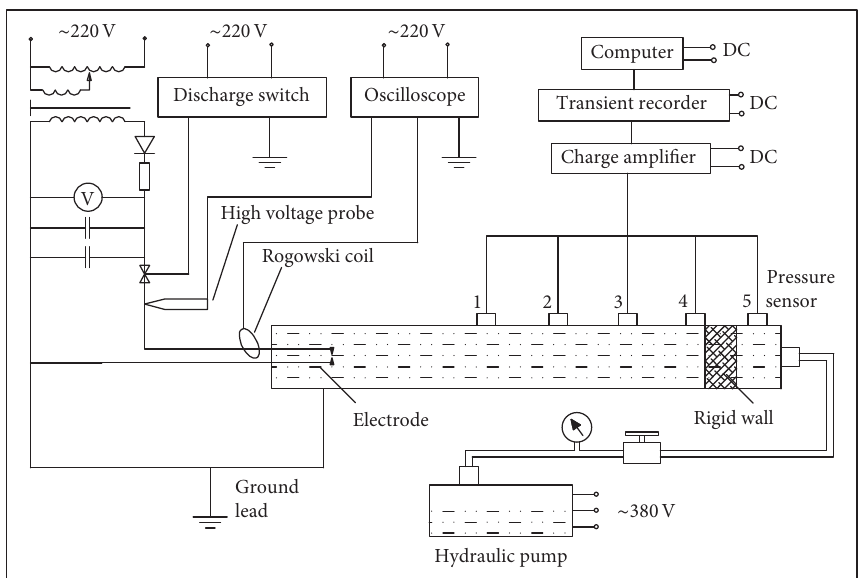
Figure 6: Experimental platform with rigid wall added (the second part of the